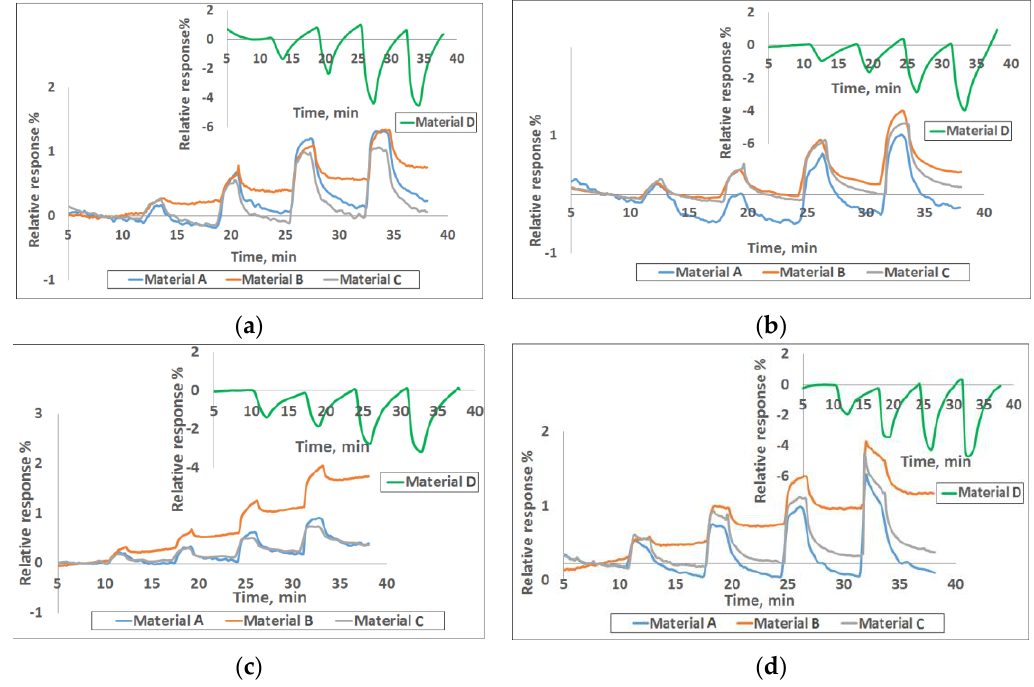
Figure 1. Response of various sensor materials to ( a ) 2, 5, 10, 25 ppm CH 4 ; ( b ) 2, 7, 17, 27 ppm CO; ( c ) 2, 5, 12, 27 ppm SO 2 and ( d ) 2, 5, 10, 30 ppm NH 3 . Materials A, B, C and D represent carboxylic-SWCNTs, sulfonated-SWCNTs, hydroxyl-SWCNTs, and polyaniline.